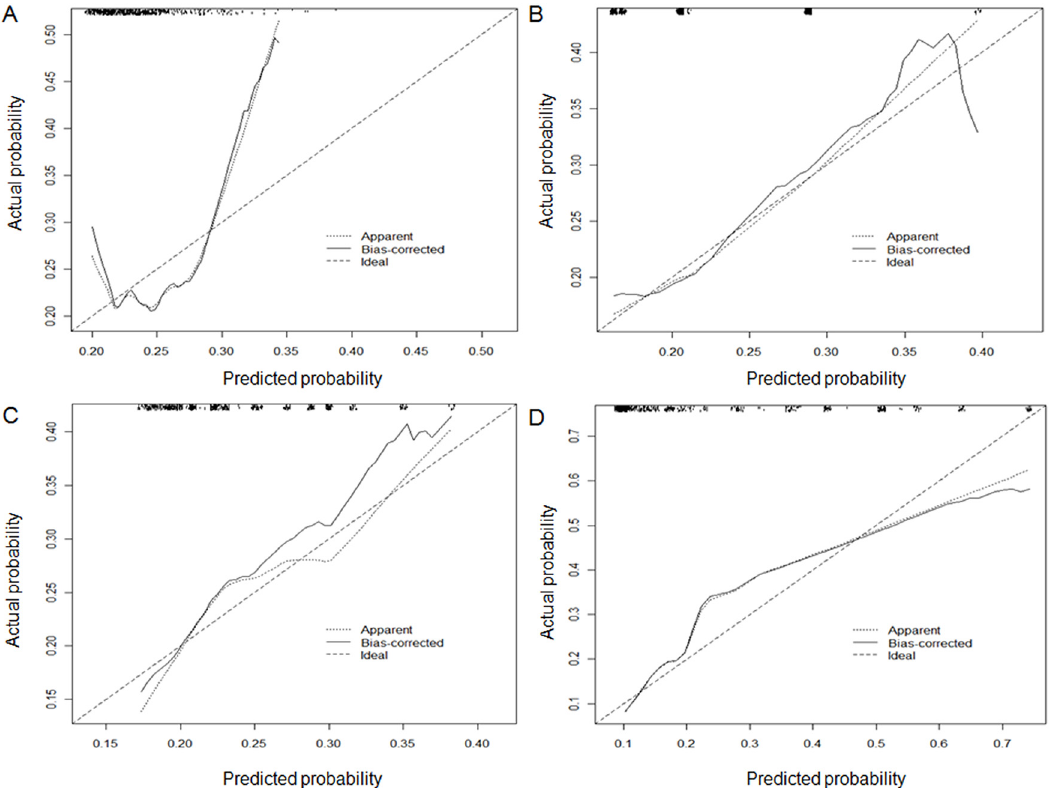
Fig 1. Calibration plots. (A) Number of lymph nodes removed. (B) Karakiewicz nomogram. (C) Clinical nodal staging score. (D) Pathologic nodal staging